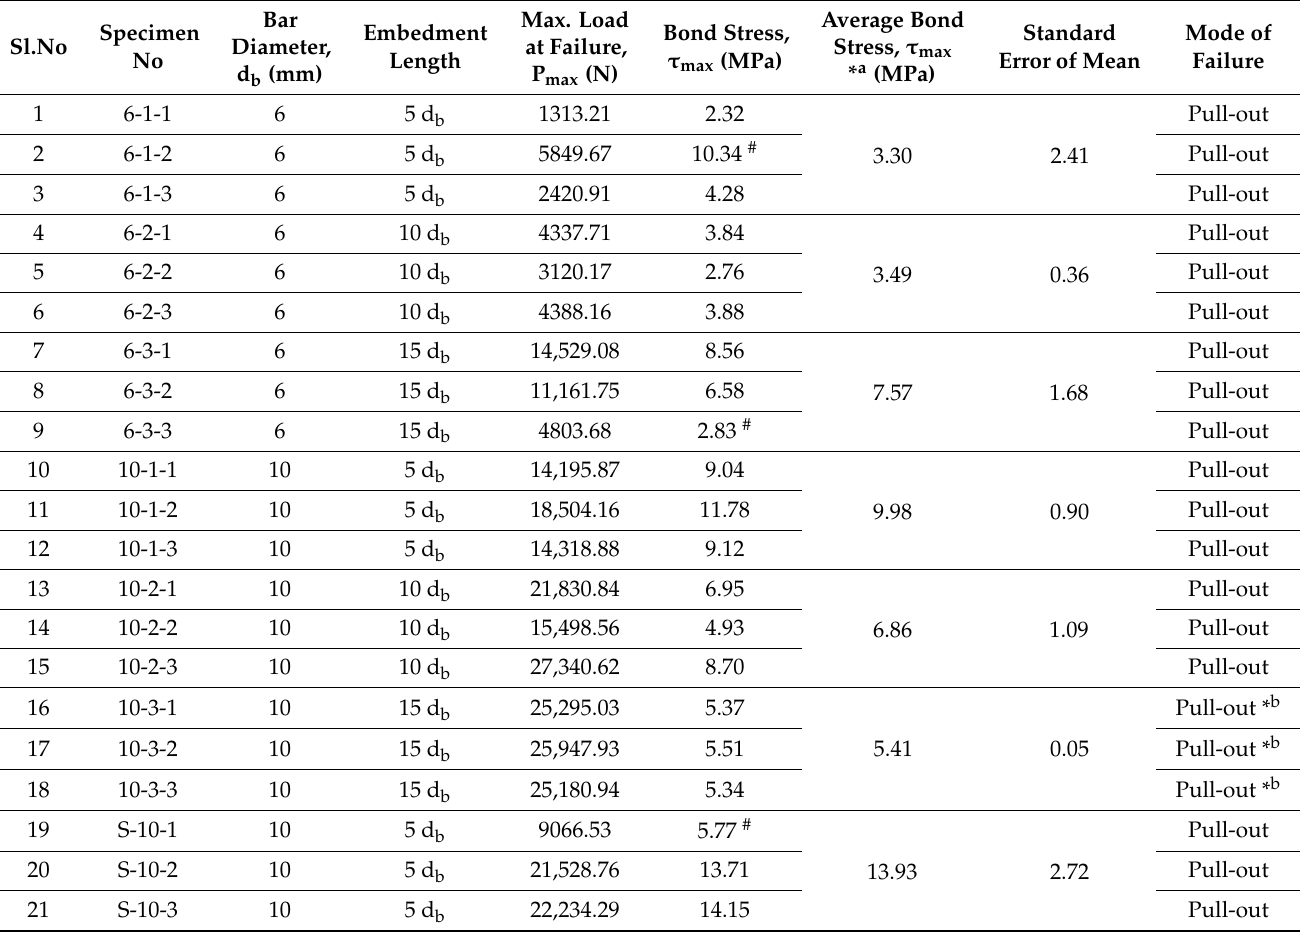
Table 4. Experimental results of the pull-out test